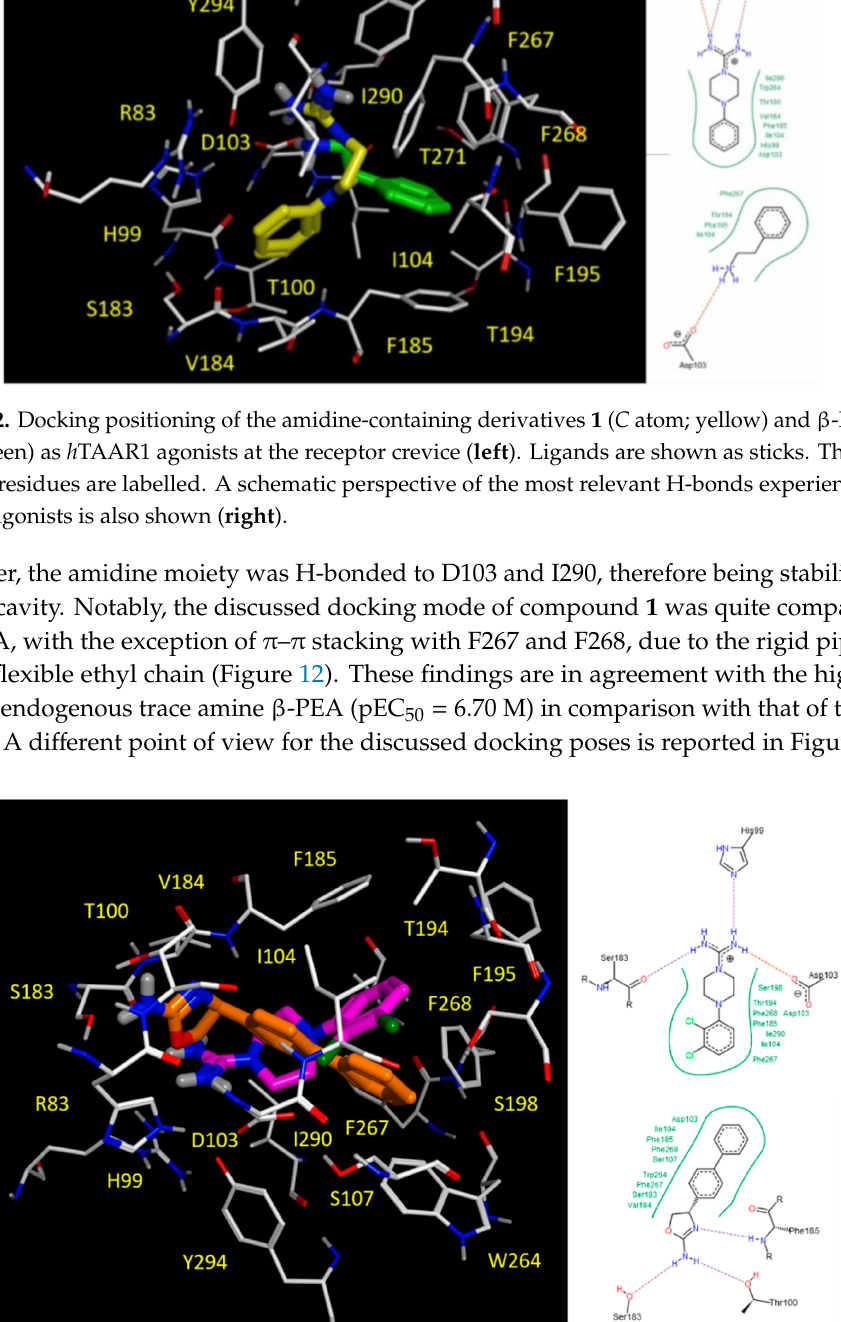
Figure 12. Docking positioning of the amidine-containing derivatives 1 ( C atom; yellow) and β -PEA ( C atom; green) as h TAAR1 agonists at the receptor crevice ( left ). Ligands are shown as sticks. The most relevant residues are labelled. A schematic perspective of the most relevant H-bonds experienced by the two agonists is also shown ( right ).